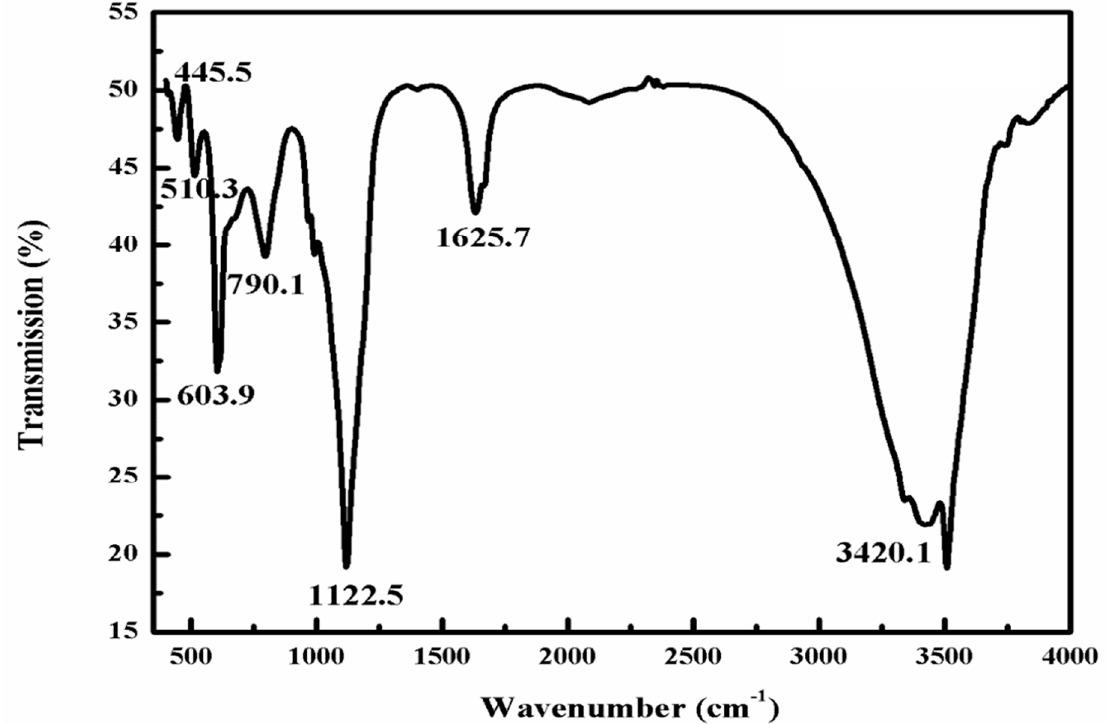
Figure 4. FTIR spectra of onion peel mediated synthesized